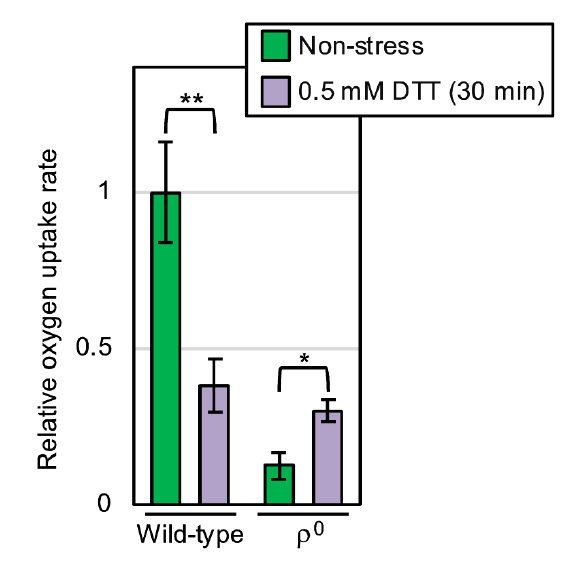
FIGURE 6 Oxygen consumption of wild-type and 0 yeast cells under non-stress and ER stress conditions. After being aerobi- cally shaken at 30°C, YPD cultures of wild-type BY4742 cells and those of the congenic  o mutant were subjected to measure- ment of the oxygen-consumption rate in the presence or ab- sence of 0.5 mM DTT. The oxygen uptake ratios were the calcu- lated as described in the Materials and Methods sections, and are normalized against that of non-stressed wild-type cells, which is set at 1.0. *: p < 0.05, **: p <